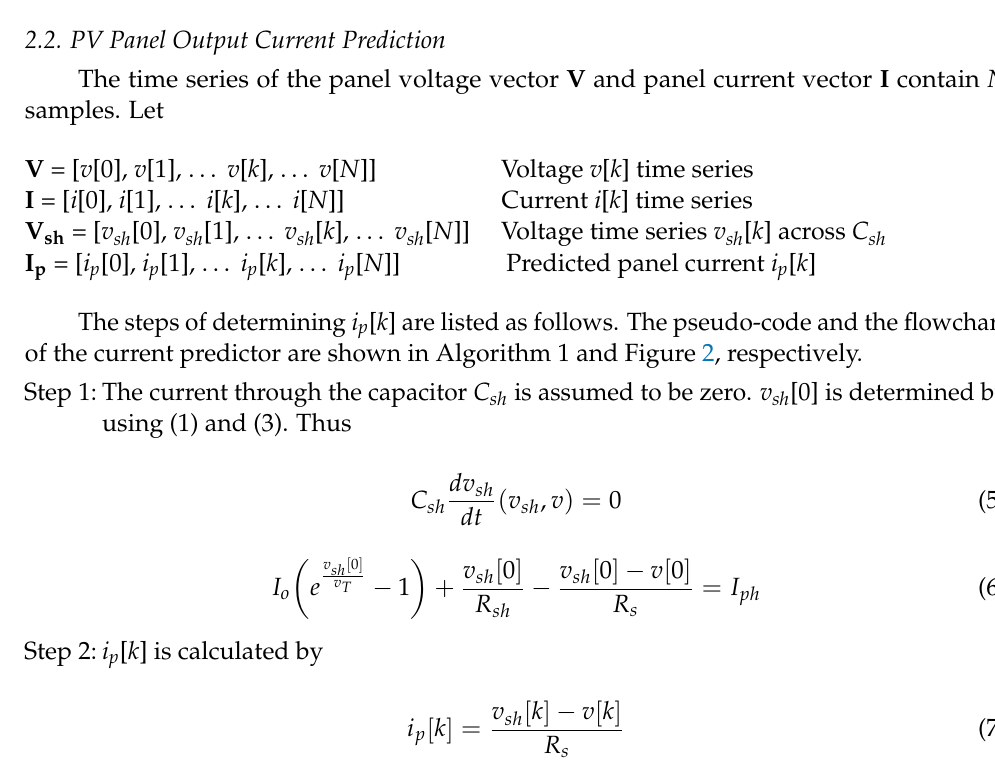
Figure 1. Equivalent circuit (or single-diode model) of a PV panel, I ph is the current source determined by incident light, D sh , C sh and R sh are model the p-n junction by diode, capacitor & resistor, R s is series resistance.